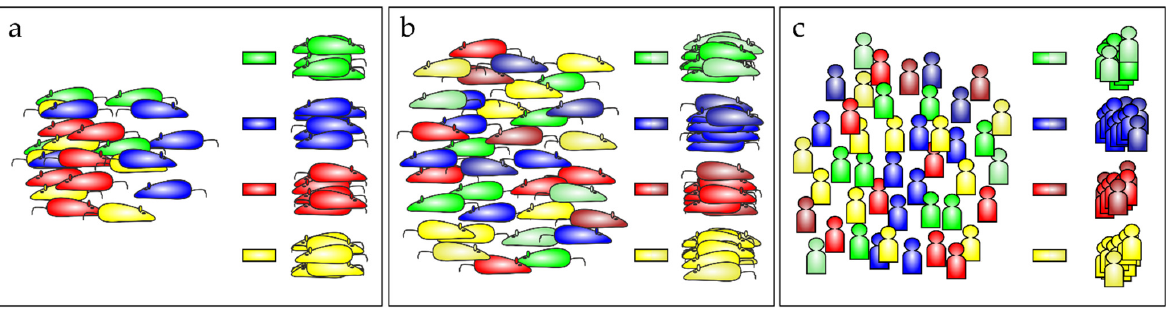
Figure 7. Precision medicine from mice to men. ( a ) Grouping animals according to the characteristics of ARDS origin or disease pattern might be advantageous for the optimization of treatment. However, ( b ) whether a more global classification, integrating some broader aspects, will provide a greater advance, needs to be tested. ( c ) This approach is also likely to be helpful for patients suffering from ARDS, allowing specific personalized treatment of the corresponding patient group.